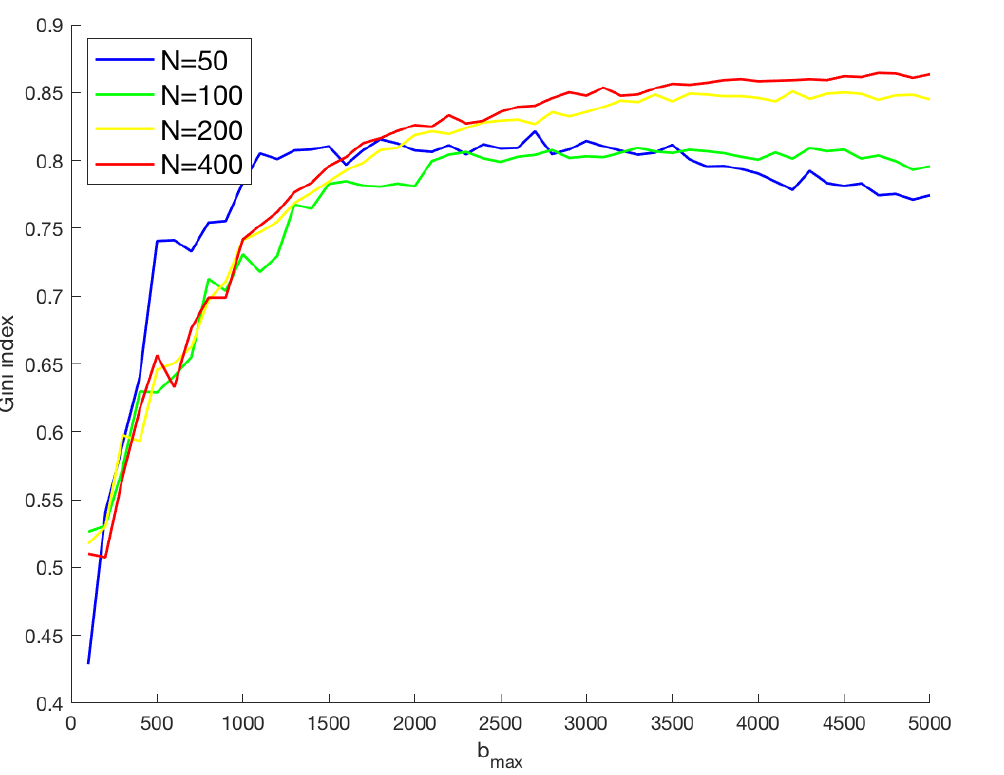
Figure 6. Plot of the Gini index at the end of the sequence of the 20 N 2 transactions vs. the value of b max for different values of the number N of the economic